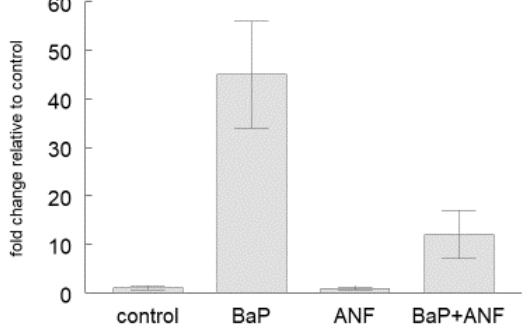
Figure 3. Inhibition of BaP induction of cypa1 mRNA by ANF. Cultured head kidney immune cells were incubated for 48 h either under control conditions, under exposure to 0.5 µ M benzo(a)pyrene (BaP), under exposure to 1 µ M α -naphtoflavone (ANF), or a combination of 0.5 µ M + 1 µ M ANF. Cells were sampled after 48 hrs, extracted and analysed for cyp1a mRNA by mean of RT-qPCR. Data are mean values of three independent in vitro incubations. The cyp1a mRNA levels in trout immune cells exposed to (BaP + ANF) are significantly ( p < 0.05) lower than those in trout immune cells exposed to